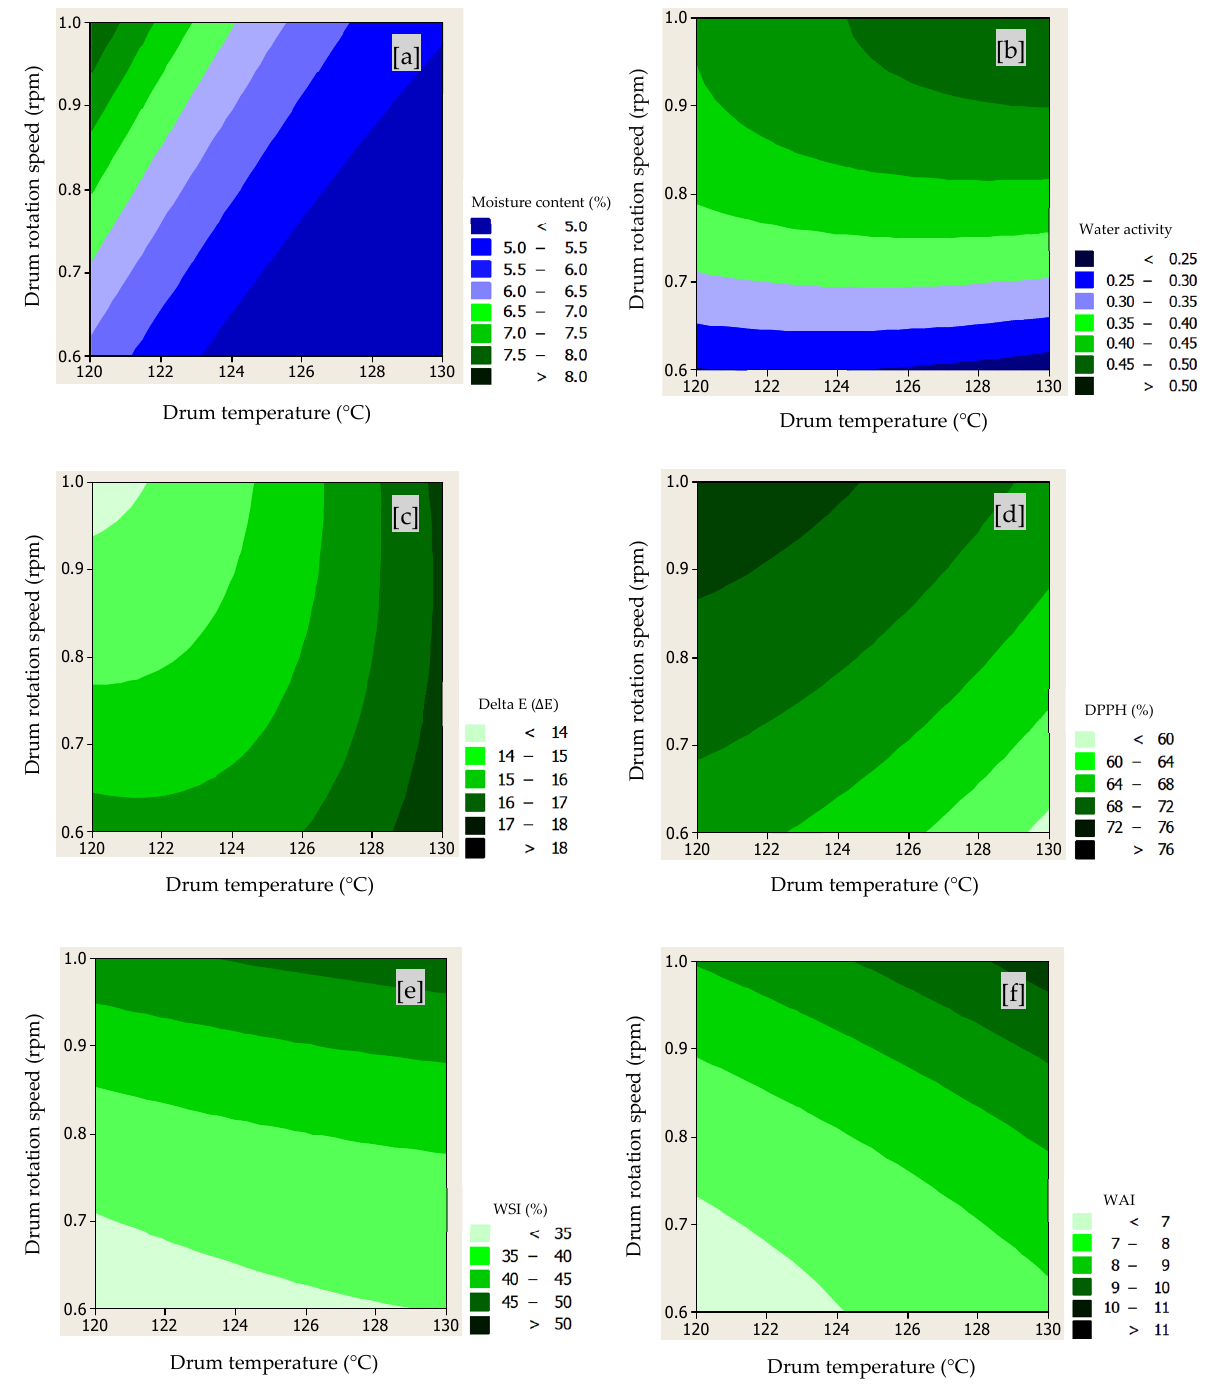
Figure 2. Contour plots for ( a ) moisture content, ( b ) a w , ( c ) Delta E ( ∆ E ) , ( d ) DPPH, ( e ) WSI, and ( f ) WAI as a function of drum temperature and drum rotation speed.